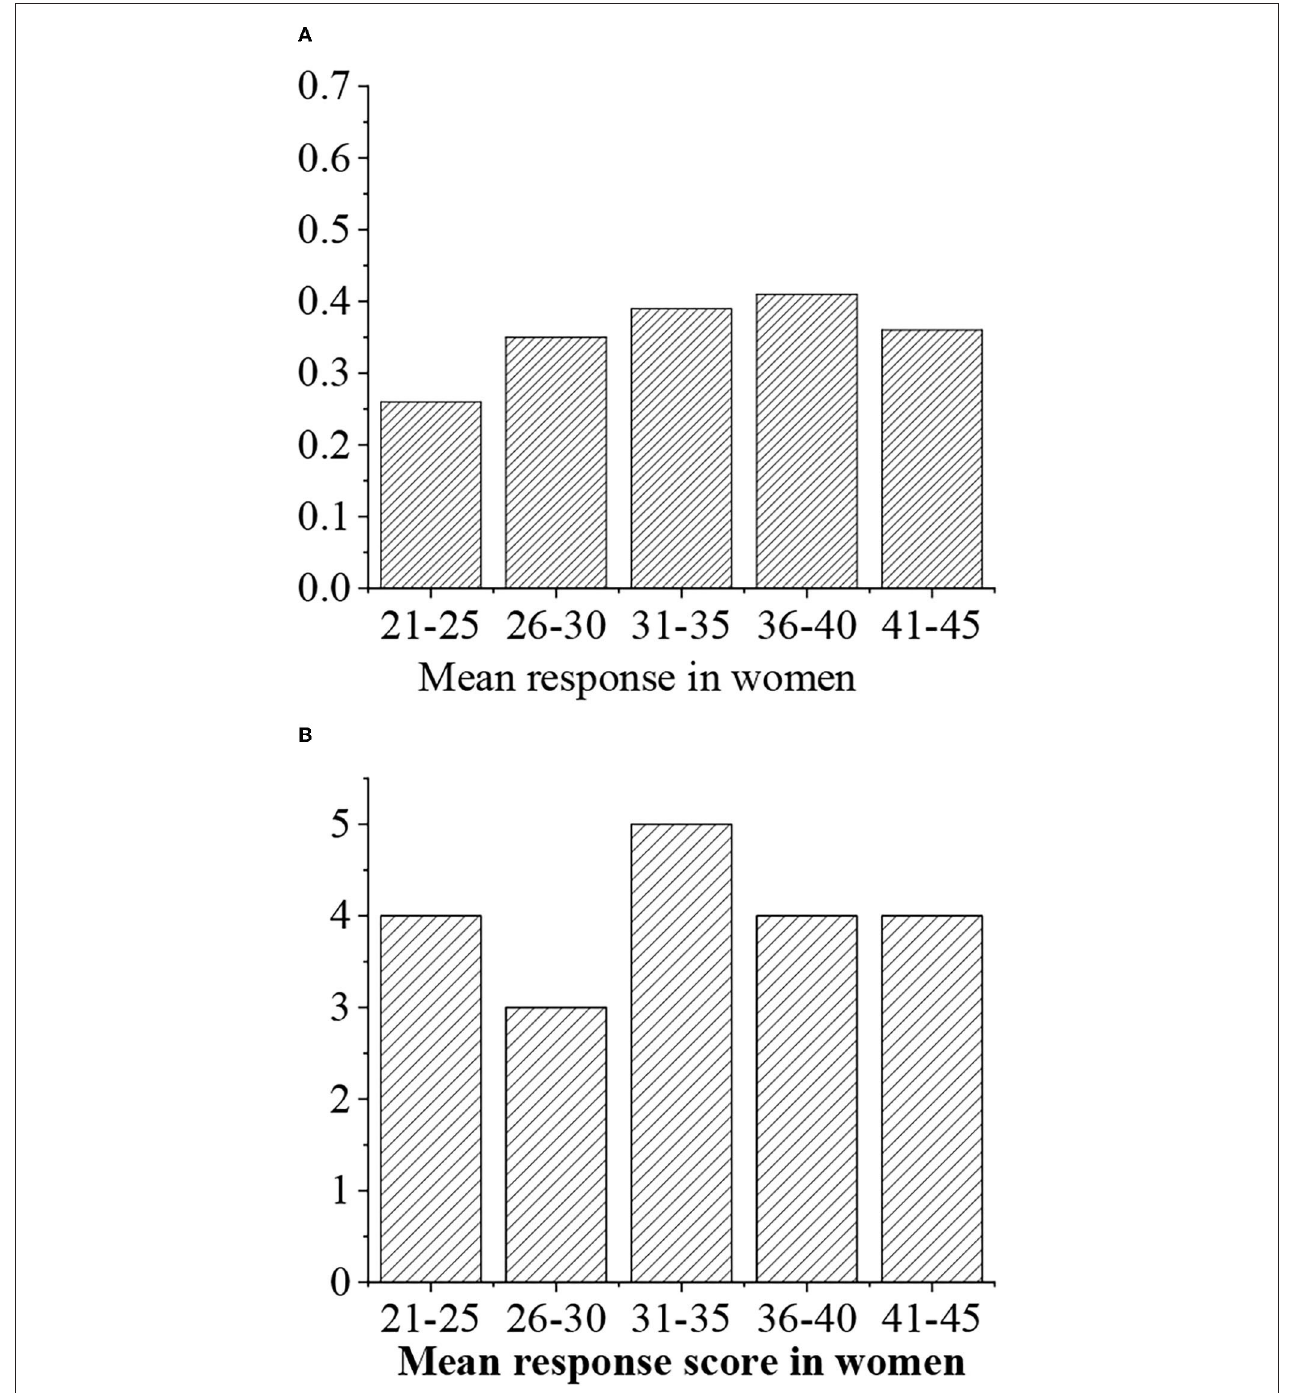
FIGURE 9 | (A) Statistical average response value for women of different ages. (B) Response value score. population with systolic blood pressure (SBP) of 120–129 mmHg and diastolic blood pressure (DBP) of 80–84 mmHg to the range of high normal values. In view of this, the classification of blood pressure is as follows. SBP < 120 is determined as “excellent” (5 points), SBP = 120–130 means the health status is “good” (4 points), SBP = 130–140 or < 90 means the